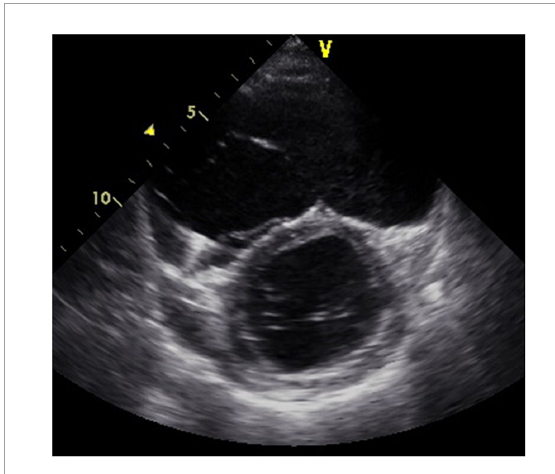
FIGURE1 Short-axis view at end-diastolic phase of transthoracic echocardiography in Case 1. Note that the right ventricle is much larger than the left ventricle.